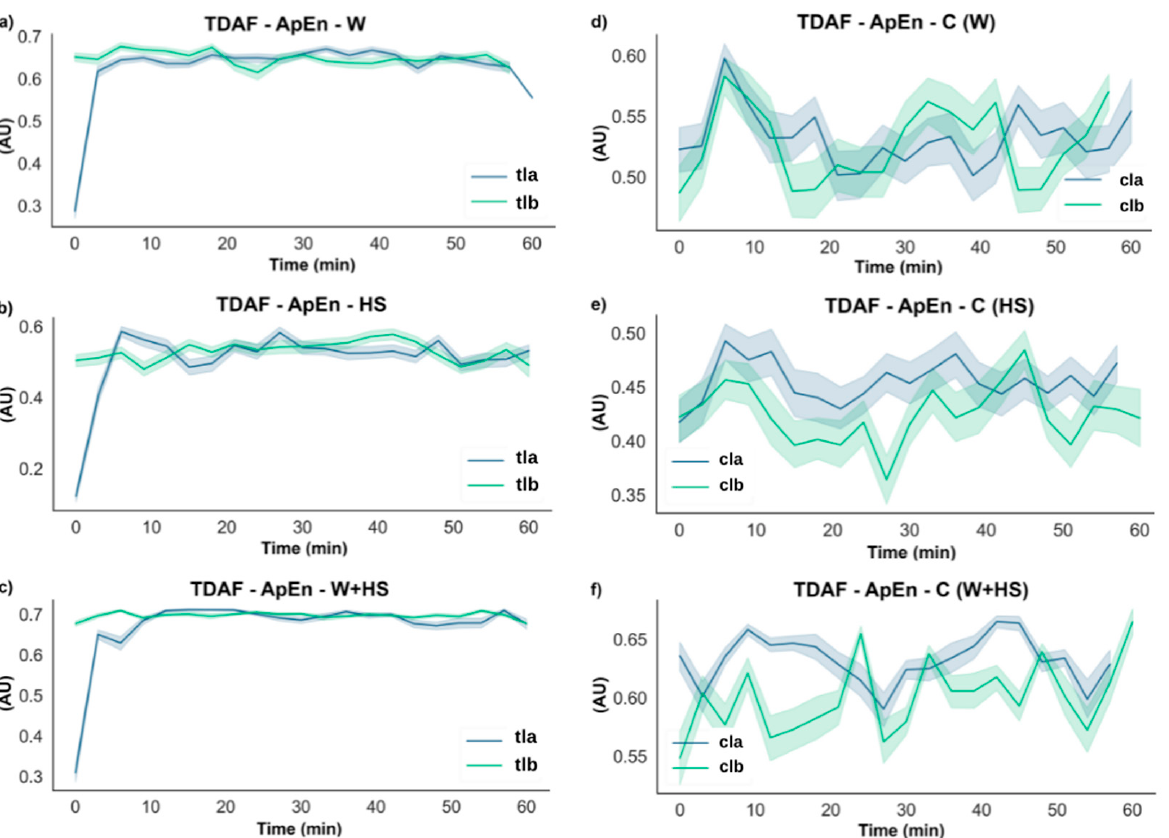
Figure 3. TDAF plots for ApEn analysis. Results for ( a ) the local wound (W), ( b ) heat shock (HS), and ( c ) wound + heat shock (W+HS). Results of the control plants for ( d – f ) wound C (W), heat shock C (HS), and wound + heat shock C (W+HS), respectively. tlb: treated local before stimulus; tla: treated local after stimulus; clb: control local before stimulus; cla: control local after stimulus. AU: arbitrary unit.